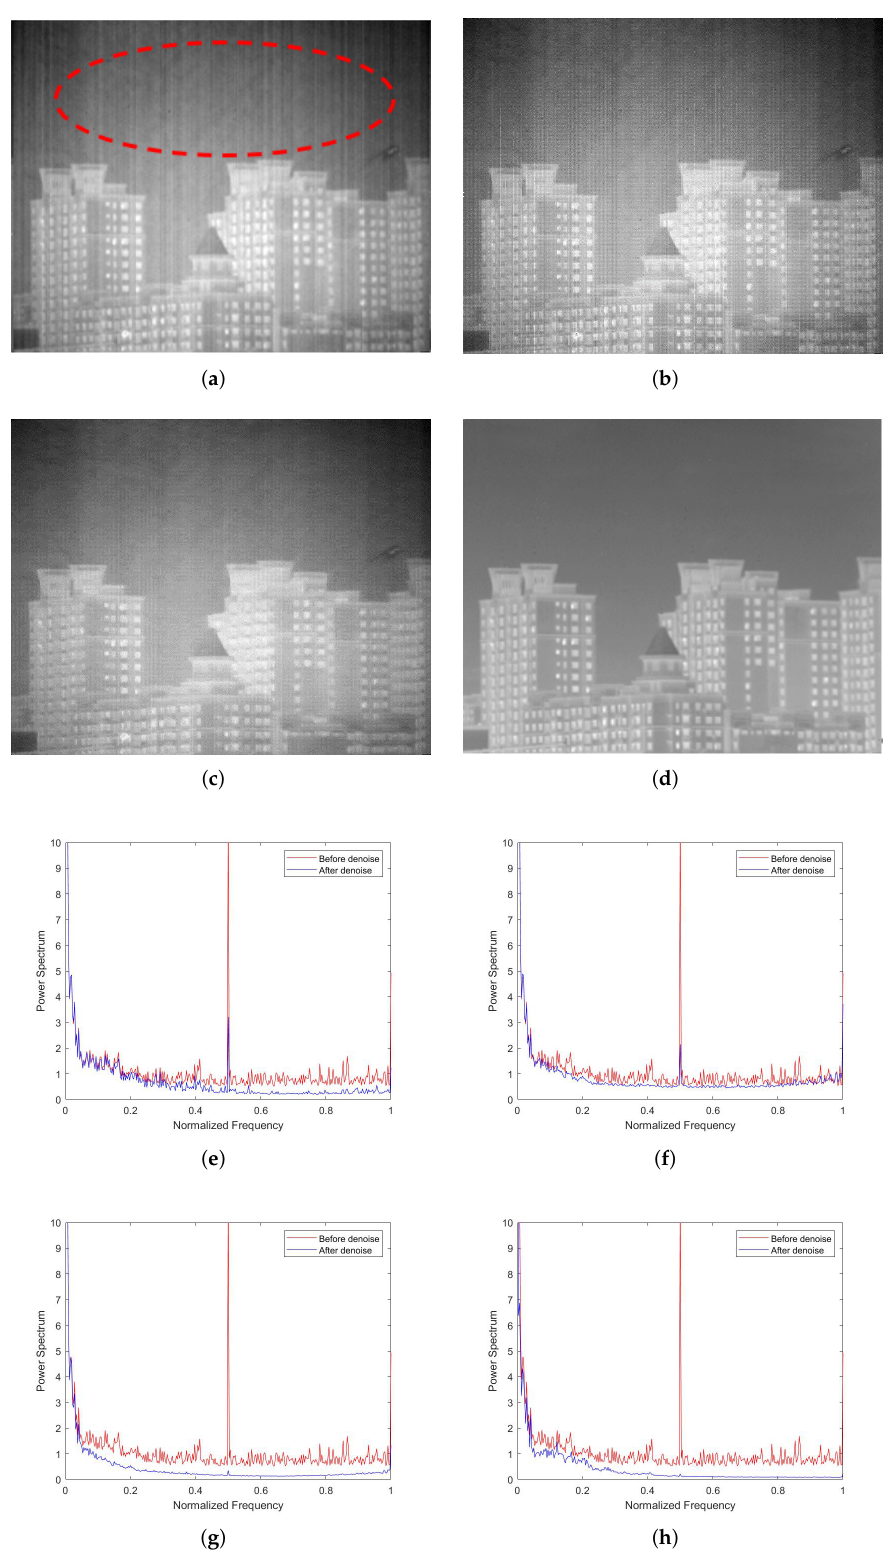
Figure 12. Denoising effects of different methods on an image of buildings against the sky : (a) MSGF; (b) WAGE; (c) TVGF; (d) our approach; (e) MSGF; (f) WAGE; (g) TVGF; (h) our approach.